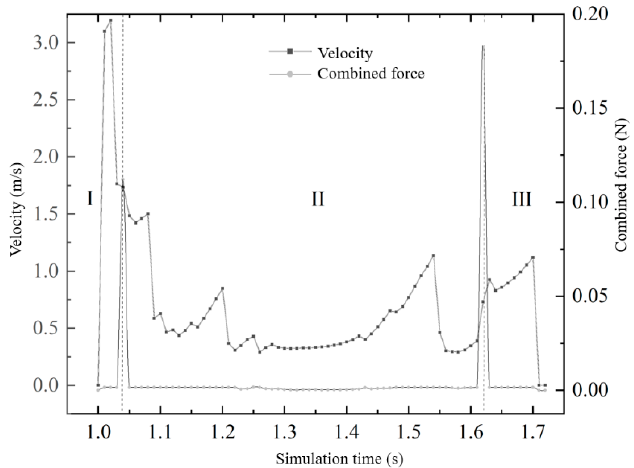
Figure 13. The plot of the seed ‐ combined force and velocity